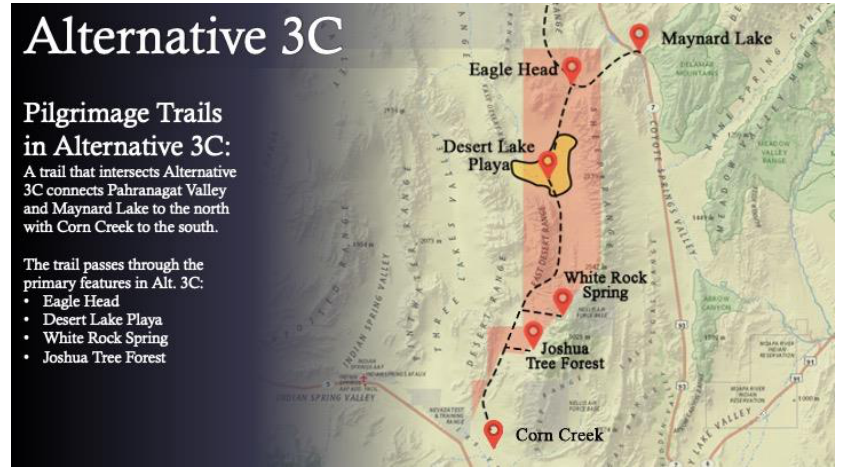
Figure 2. Alternative 3C in pink and places studied located along the pilgrimage trail [40]. The Nevada study area extends west to east from the Desert Range along the current eastern boundary of the UTTR. It also extends from the north to south trending along the crest of Sheep Mountains (Figure 3). It extends from north to south from Pahranagat Val- ley to the Spring Mountains. The pilgrimage trail extends from Pahranagat Valley and Black Butte to Eagle Head, to the Desert Lake Playa, along the trail to White Rock Spring, through the Joshua Tree Forest and is anchored in the south by Corn Creek and the Spring Mountains. Pilgrimage trails and secular travel trails have been identified throughout the broader area. Some of these trails are identified in the 2018 Nellis Integrated Report Meet- ing map below along with the boundary of the UTTR in tan and the DNWR in green.